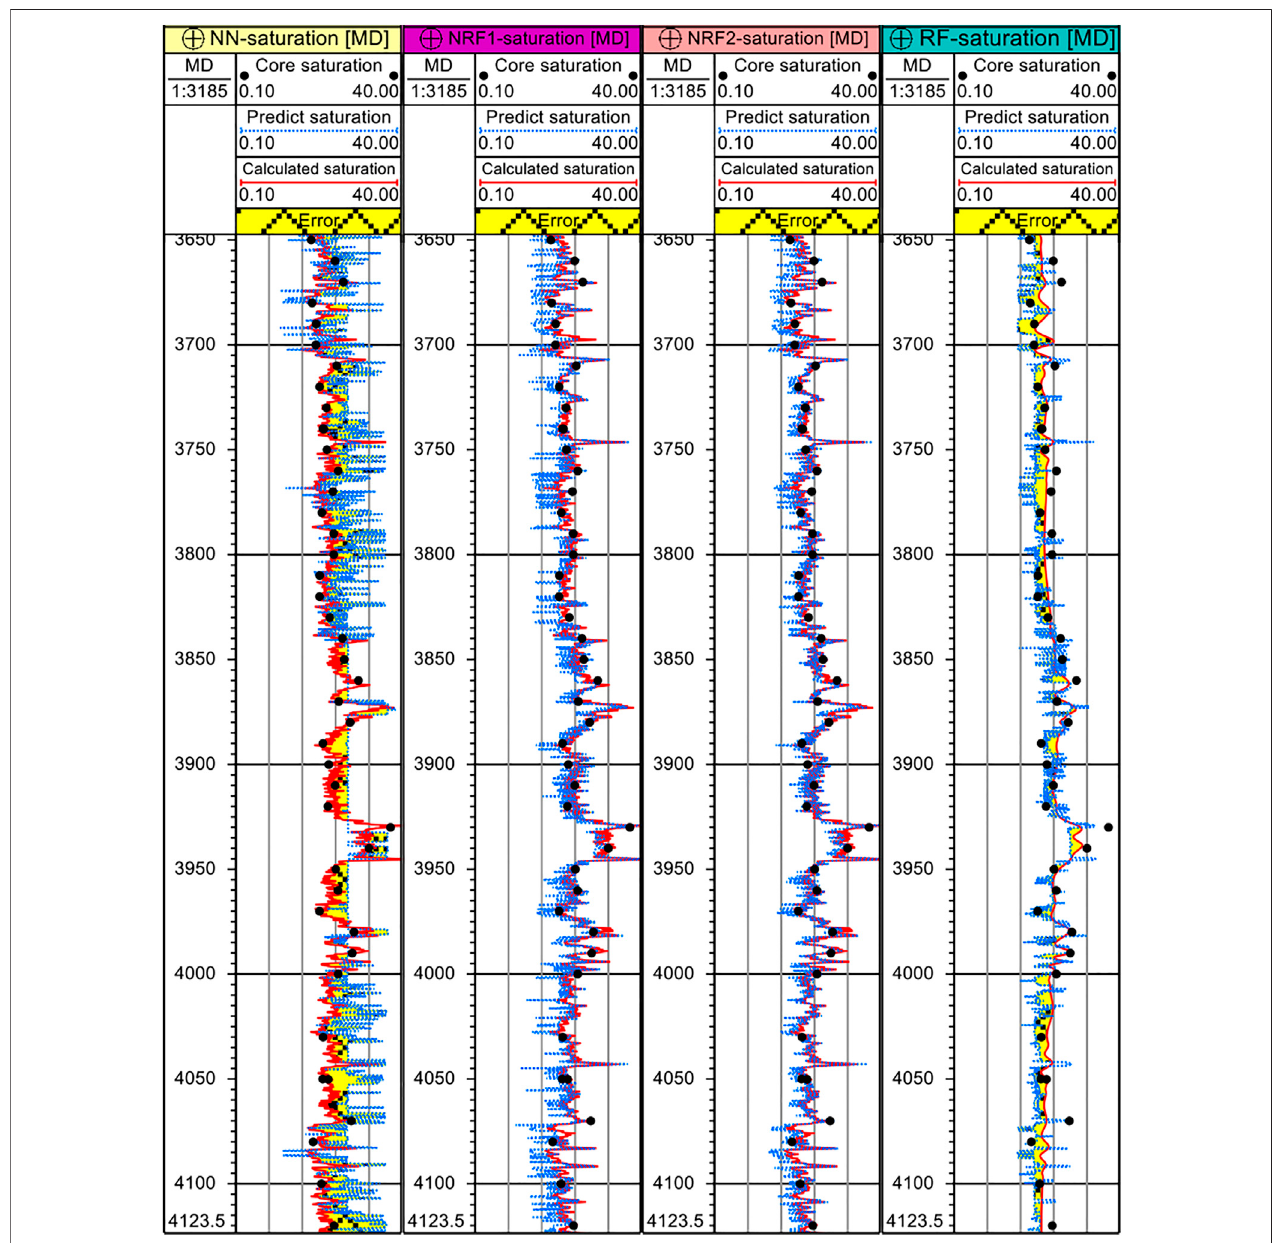
FIGURE 8 | Comparison results of different models for saturation (depth: 3650 – 4100